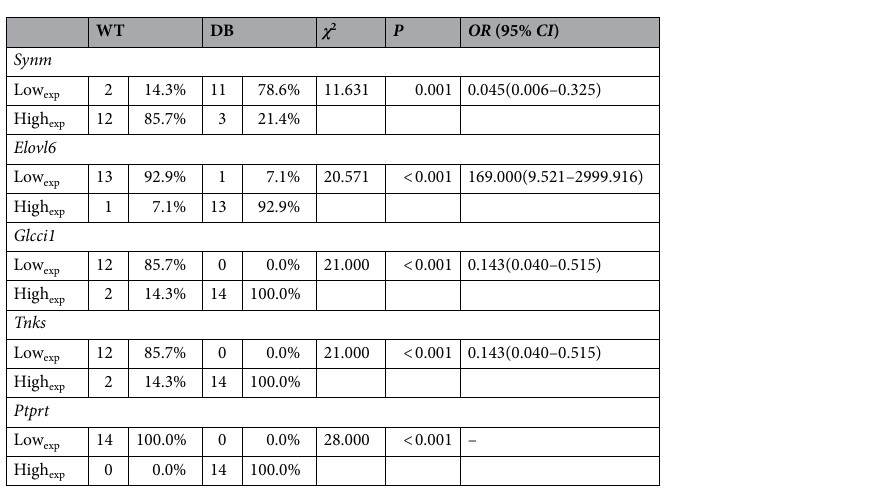
Figure 4. Screening of marker genes related to T2DM based on LASSO regression. ( A ) Cross validation plot for the penalty term. When logλ = − 0.775, a minimal root mean square error (RMSE) and 5 non-zero coefficients were obtained. ( B ) LASSO regression coefficients over different values of the penalty parameter. ( C ) Expression of the 5 marker genes in WT and DB groups. *** P < 0.001.